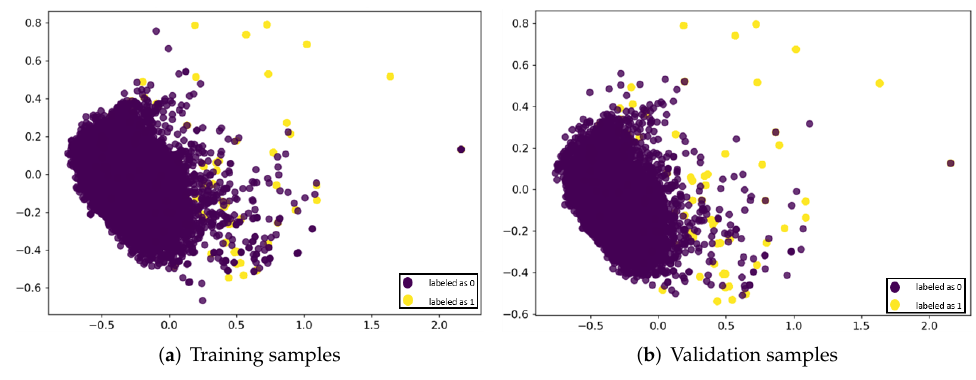
Figure 4. Similarity feature vectors